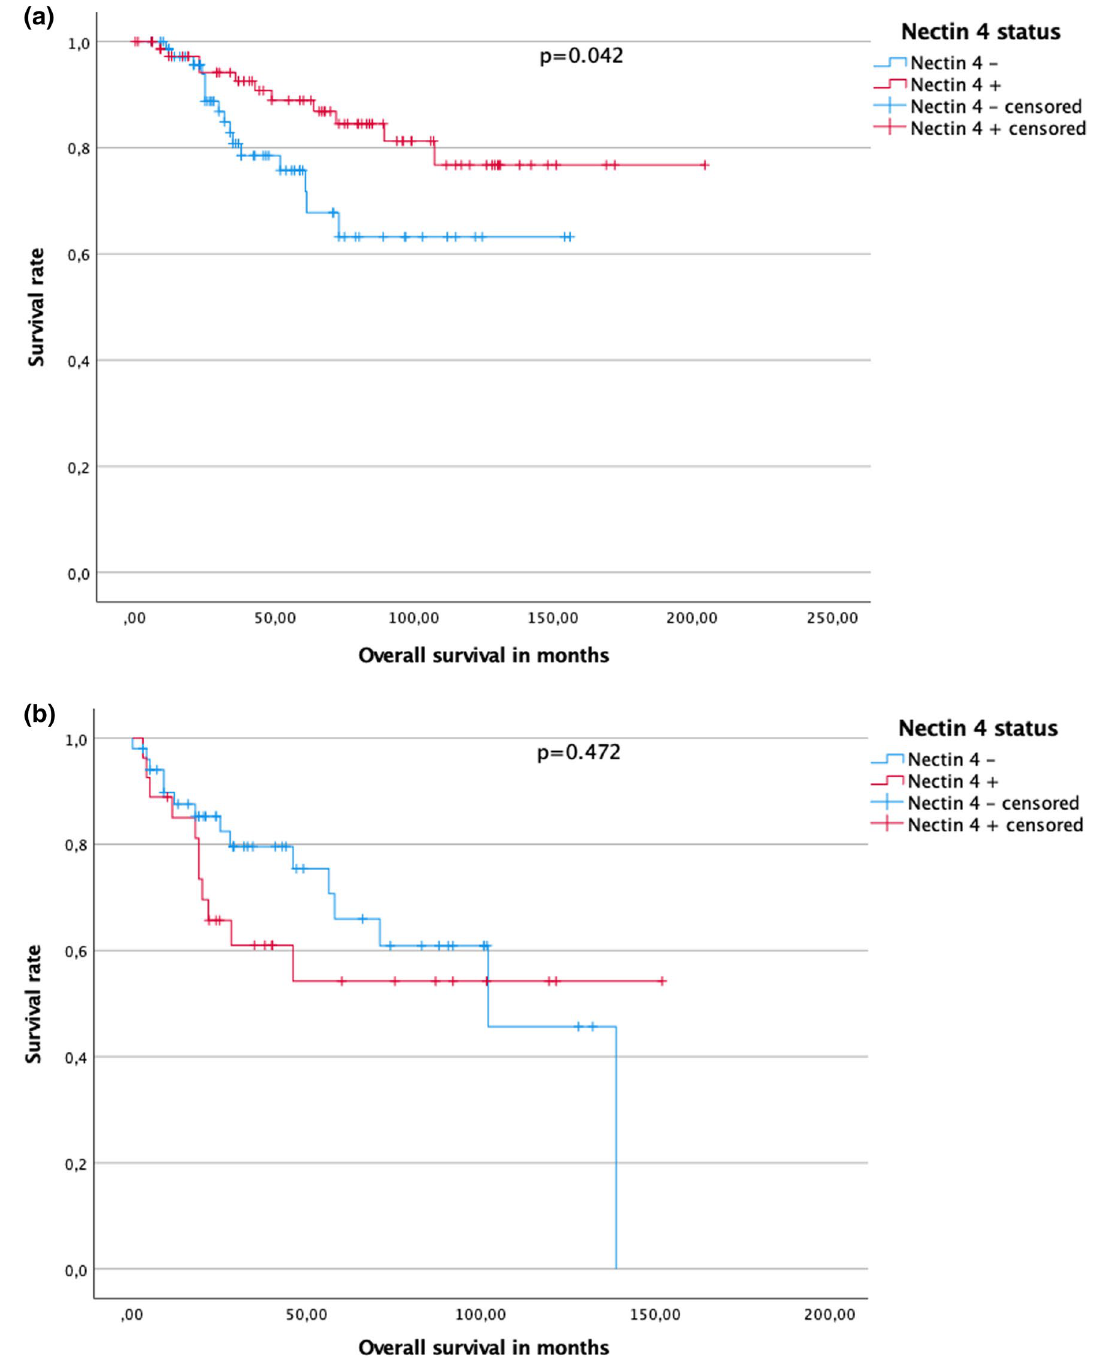
Fig. 4 a Cumulative survival in patients with papillary renal cell carcinoma type 1 in dependence of Nectin-4 status. b Cumulative survival in patients with papillary renal cell carcinoma type 2 in dependence of Nectin-4